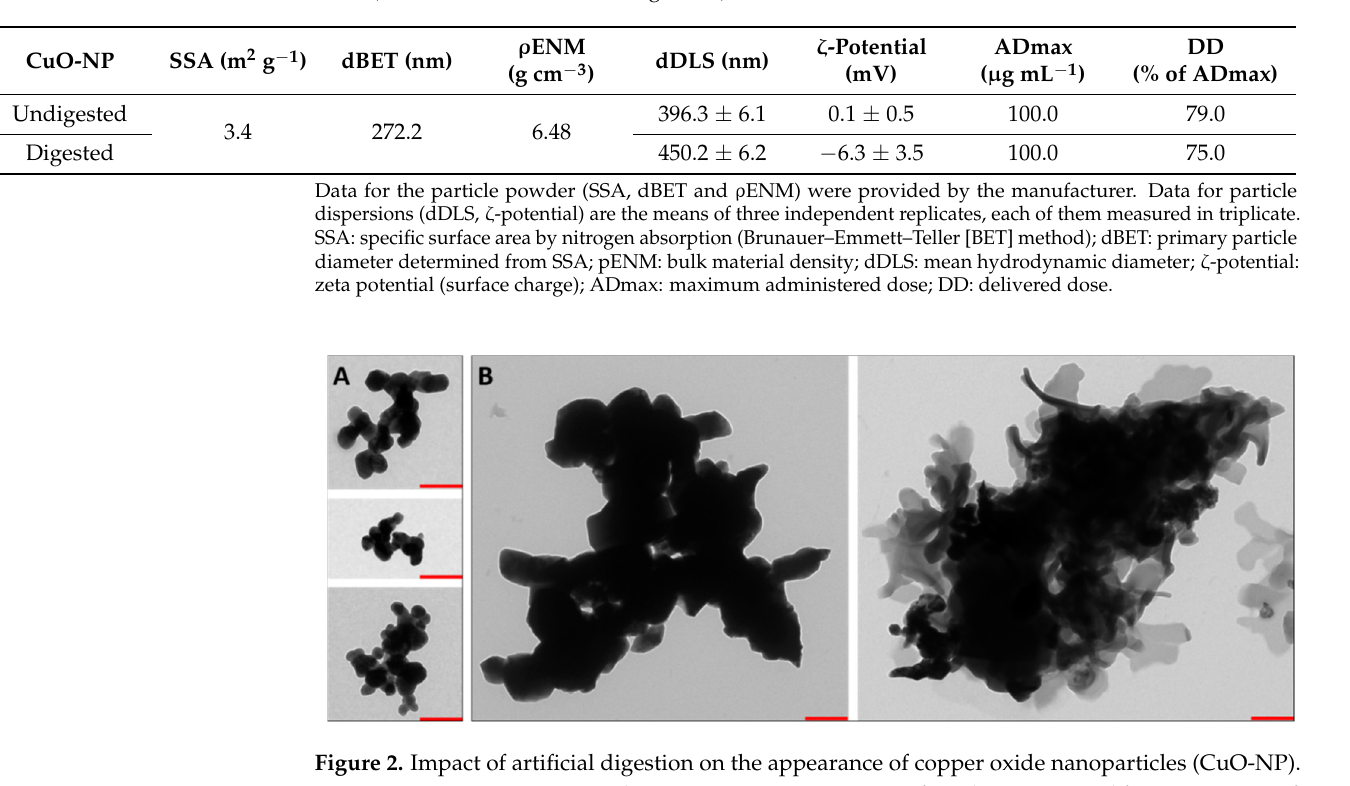
Table 1. Physicochemical properties of copper oxide nanopowder and copper oxide particle disper- sions (before and after artificial digestion).